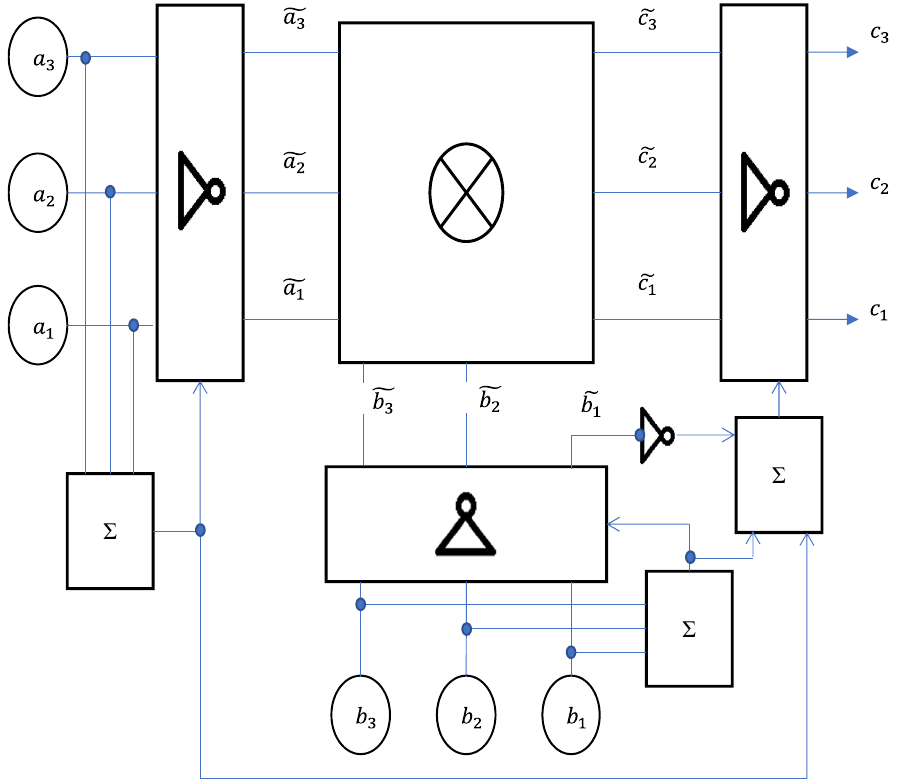
Figure 3. Block diagram of the modulo multiplier by seven (Image was generated in PowerPoint Microsoft 365 https:// www. micro soft. com/ en- ww/ micro soft- 365/ power